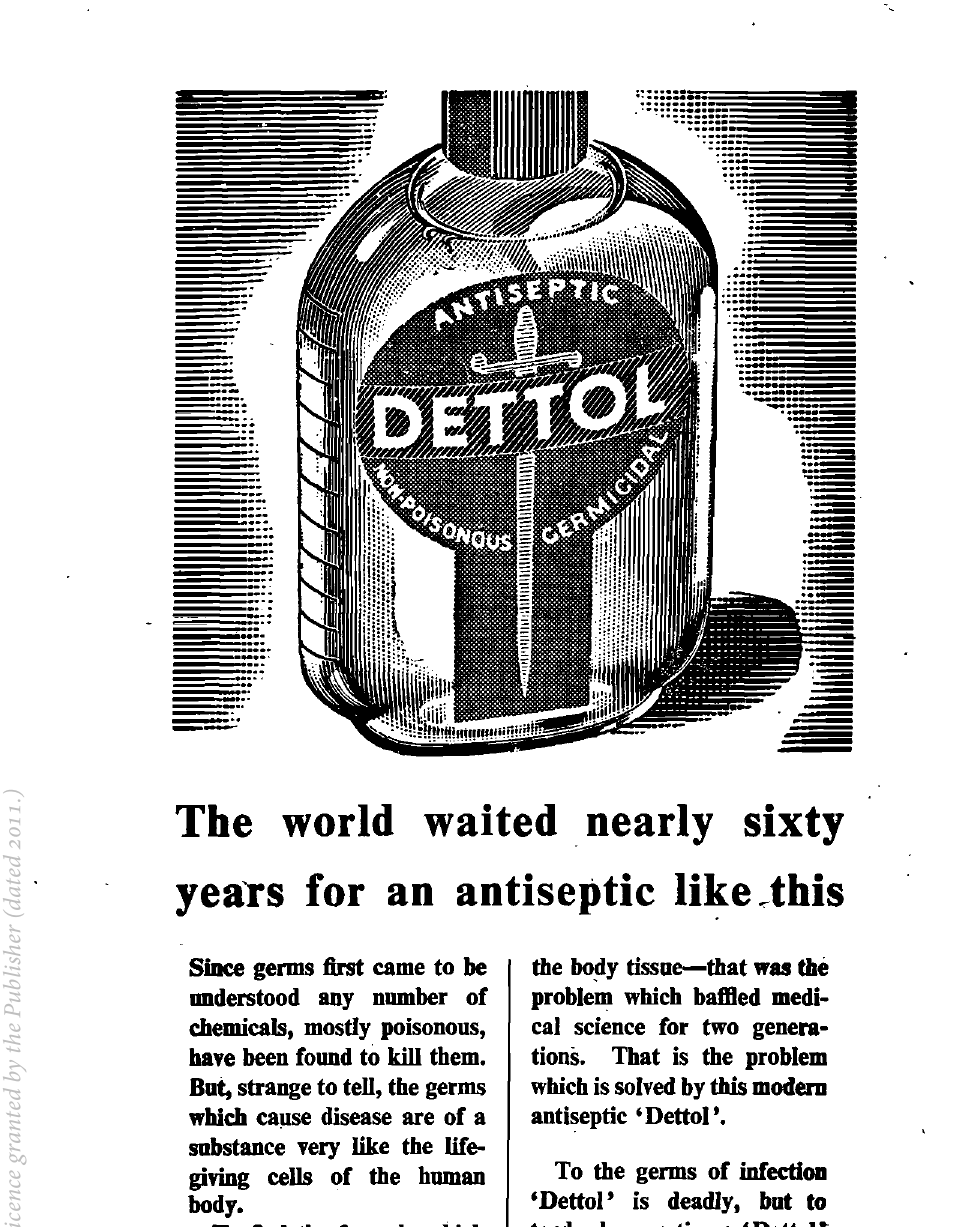
li~e ~this problem which bafHed